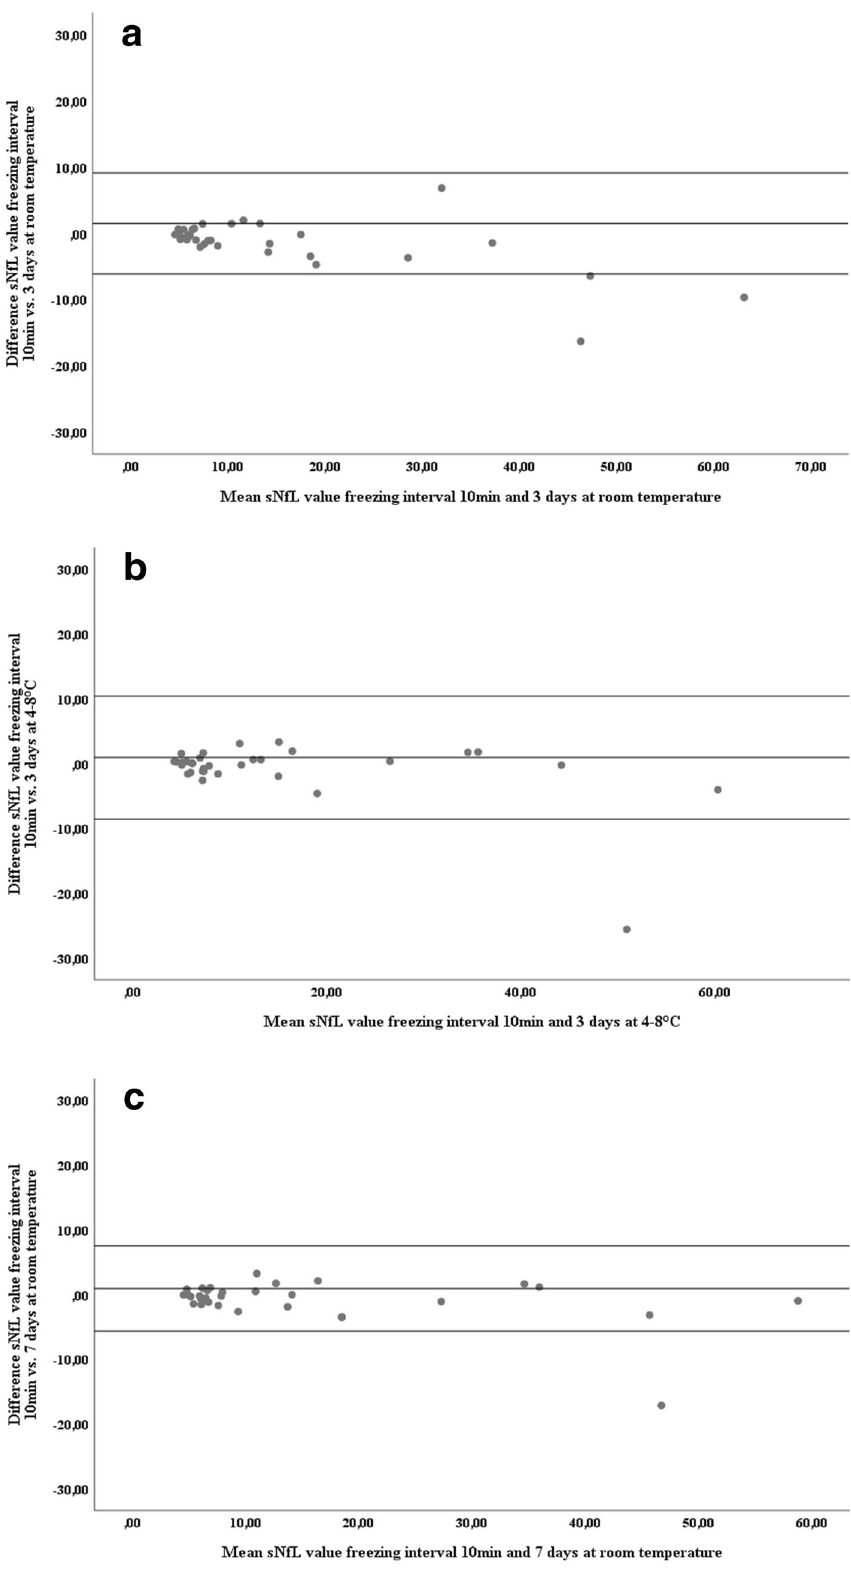
Figure 1. Differences in sNfL concentrations after different freezing intervals. Bland–Altman plot showing the differences in sNfL concentration between two groups of immediate processing and delayed freezing, ( a ) freezing after 10 min compared to 3 days at room temperature, ( b ) freezing after 10 min compared to 3 days at 4–8 °C, ( c ) freezing after 10 min compared to 7 days at room temperature. Single dots represent samples at two conditions with their mean concentrations on the x-axis and their difference in concentration on the y-axis. The three horizontal lines represent the mean difference (middle) and the mean difference plus 1.96 × SD of that difference (upper) and mean difference minus 1.96 × SD of that difference